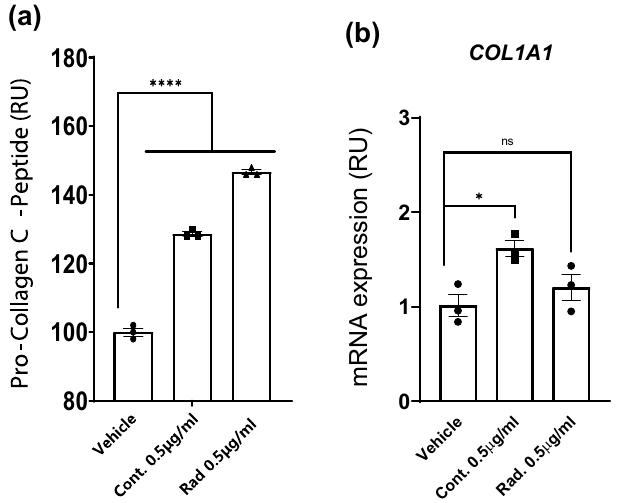
Figure 4. A mixture of plant extracts from agrimonia, houttuynia, licorice, peony, and phellodendron (hereafter AHLPP) promotes collagen synthesis in Hs68 cells. Hs68 cells were treated with indicated concentration of control and γ-irradiated AHLPP extracts. ( a ) Protein levels of procollagen C-terminal peptides in supernatant were determined via antibody-based colorimetric analysis. ( b ) mRNA expression of Collagen type 1 alpha 1 ( COL1A1 ) was analyzed. The same volume of water was used as vehicle control. Asterisks indicate statistical significance. One-way ANOVA revealed statistical significance. * p < 0.05, **** p < 0.0001, ns